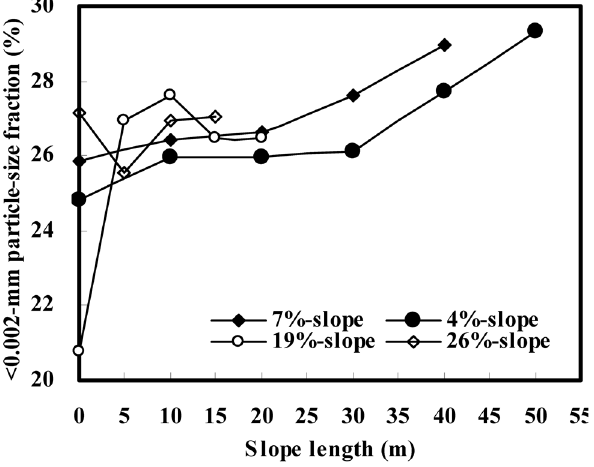
Figure 1. Distribution of the , 0.002-mm particle-size fraction on eroded